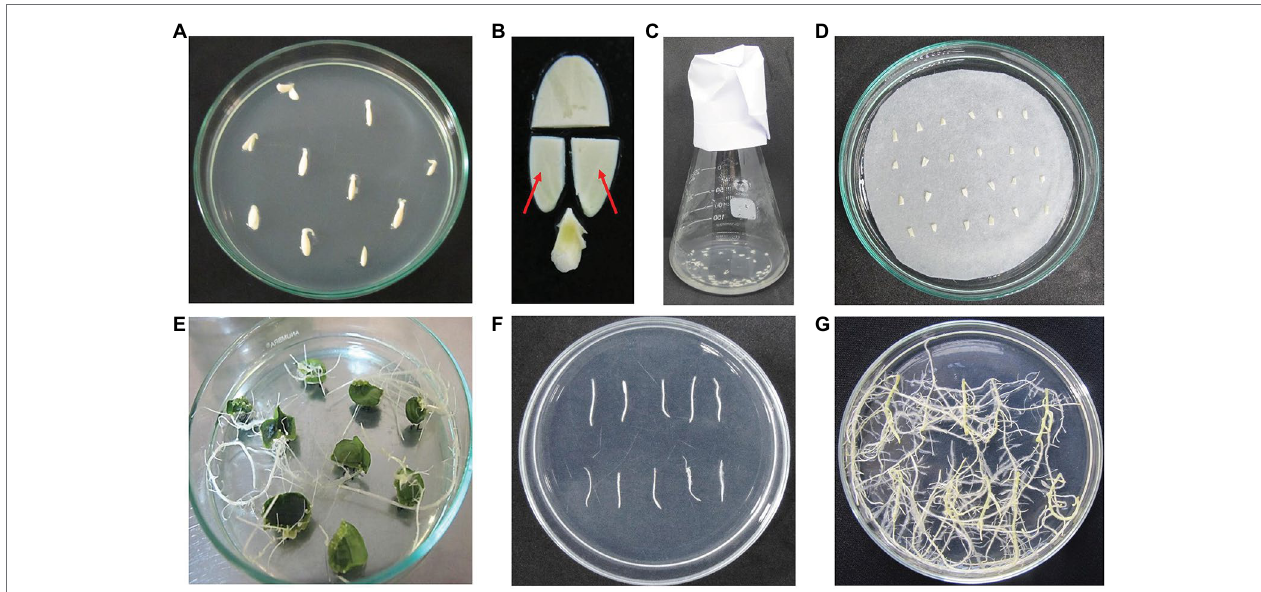
FIGURE 1 | Main steps of cucumber hairy root induction. (A) The 2-day-old seedlings; (B) cotyledon explants preparation. The red arrows indicate the cotyledon fragments used for bacterial infection; (C) cotyledon fragments were soaked in bacterial suspension; (D) the infected explants on co-cultivation medium; (E) hairy root formation at 20 days after co-cultivation; (F) hairy root fragments were transferred to a new medium; (G) hairy roots developed on hairy root culture